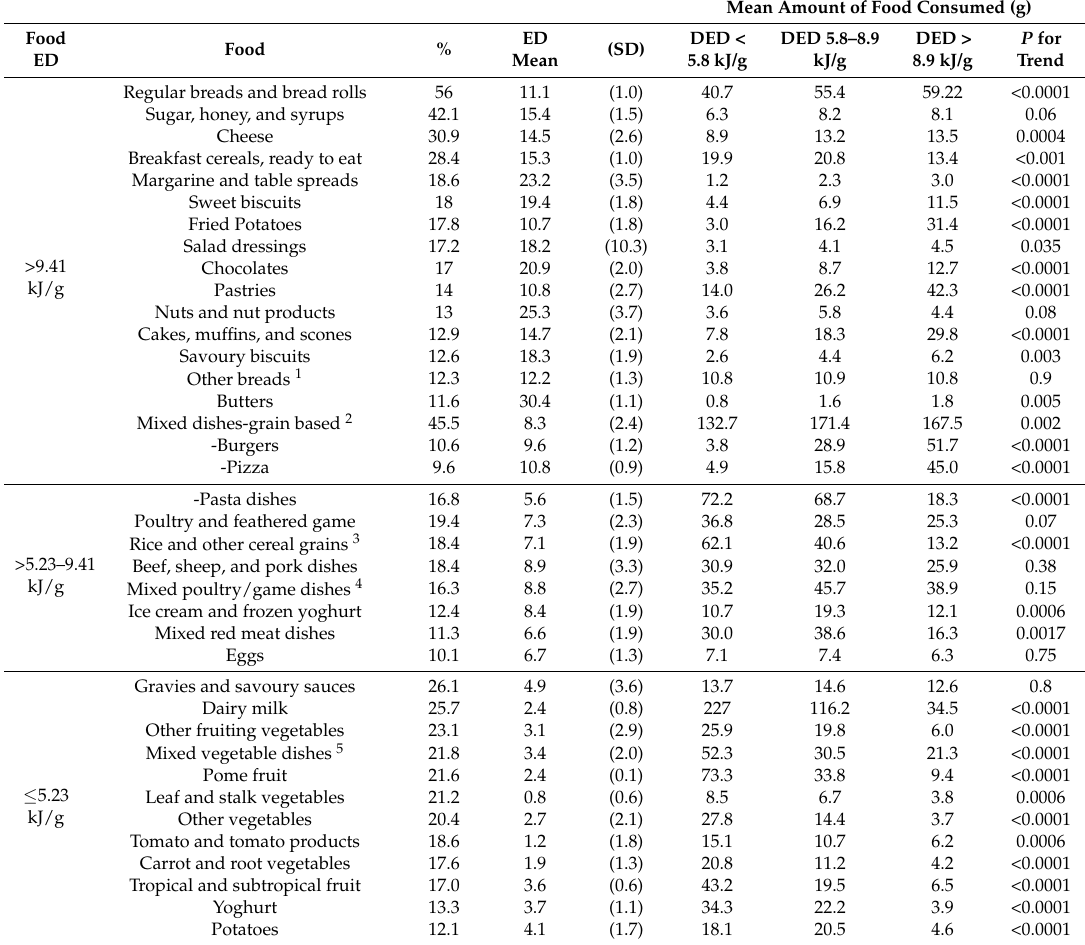
Table 2. Proportion of consumers (%), energy-density, and the amount consumed by those with dietary energy-density <5.8 kJ/g, 5.8–8.9 kJ/g, and >8.9 kJ/g for foods reported by Australian